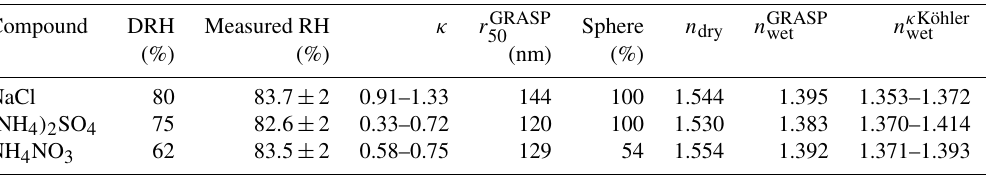
Table 1. Predicted and retrieved real refractive indices, median radii in volume and spherical fractions for the three artificially generated aerosols. Also shown are the deliquescence relative humidities (DRH), κ values, and dry real refractive indices taken from the literature. All refractive indices are at 532nm.